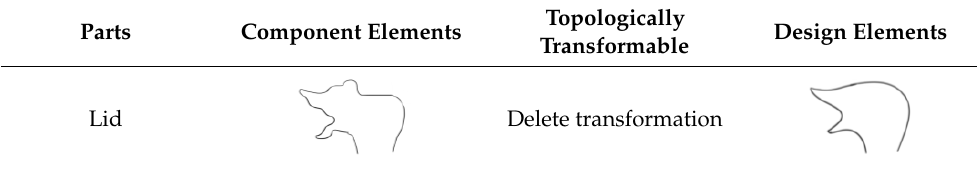
Table 6. Part lid deletion transformation.